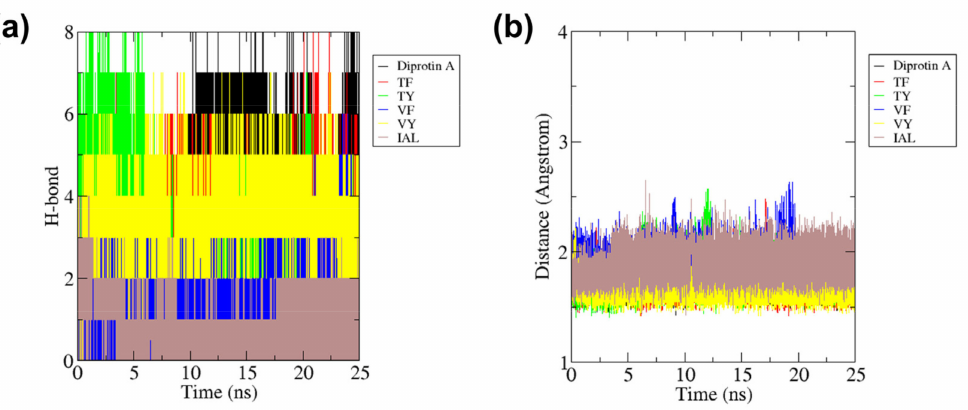
Figure 8. ( a ) Total number of hydrogen bonds interactions between DPP-IV and each peptide and ( b ) intermolecular distance of DPP-IV with peptides during 25 ns of the molecular dynamics simulation